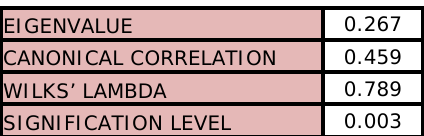
Table 2. “Eigenvalue, canonical correlation, Wilks Lambda and signification level of the discriminant function”. Source: